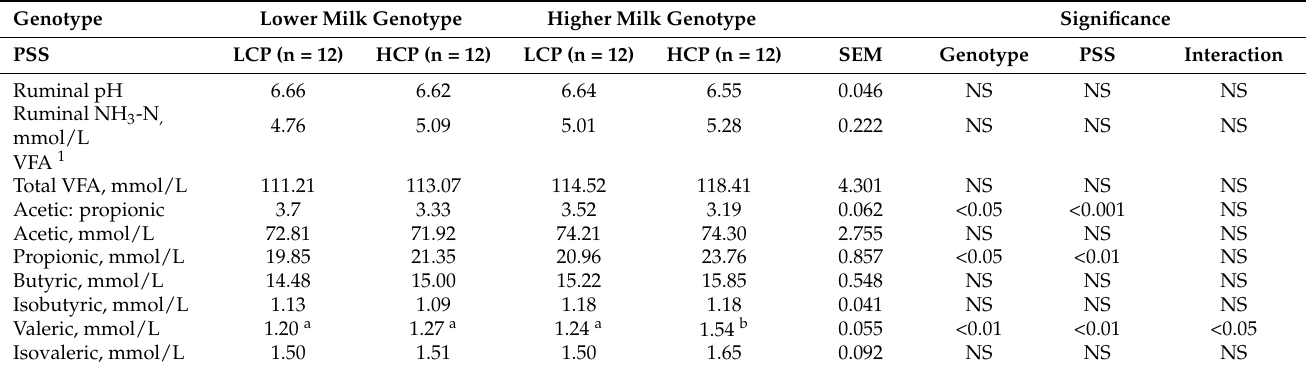
Table 4. Effects of protein supplementation strategy (PSS) and genotype and on ruminal fermentation